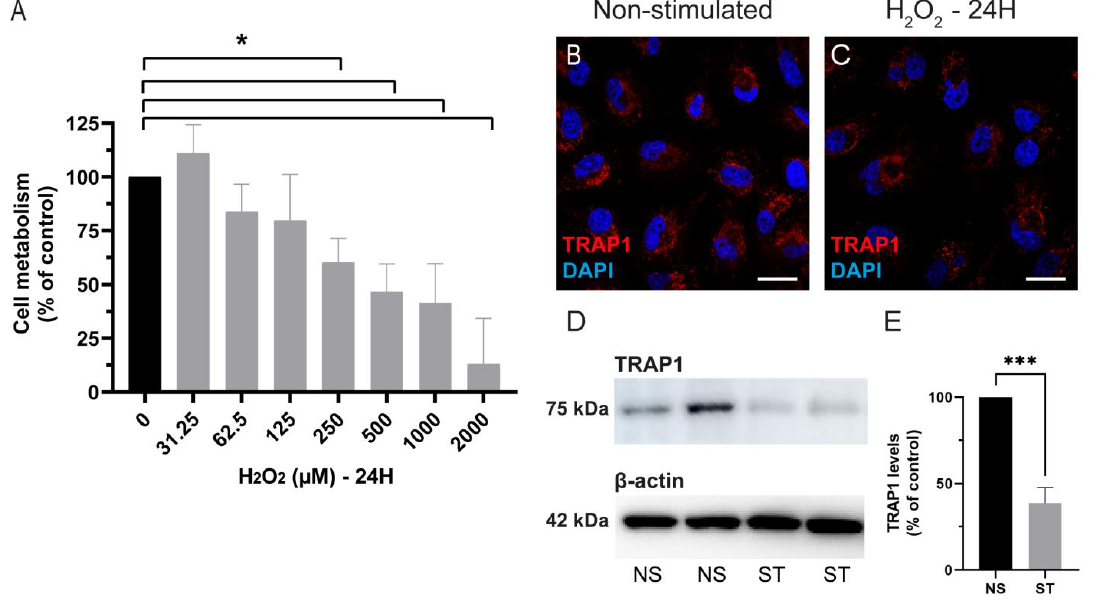
Figure 2. TRAP1 levels decrease upon challenge with hydrogen peroxide. ARPE-19 cells were treated with different doses of H 2 O 2 (0; 31.25; 62.5; 125; 125; 250; 500; 1000 and 2000 μM ) for 24 h ( A ). The dose of 500 μM was selected for the following experiments. ARPE-19 cells were treated, or not, with 500 μM H 2 O 2 for 24 h ( B – E ). Scale bars in ( B , C ) : 20 μm. Exposure to 500 μM H 2 O 2 for 24 h resulted in lower levels of TRAP1. NS: Non-stimulated (black bars); ST: stimulated with H 2 O 2 (grey bars). The values are presented as a percentage of the control (non-treated cells). Cell metabolism was assessed using the resazurin assay. Four independent experiments were performed ( n = 4). For the graph ( A ), statistical significance was calculated by using the Mann – Whitney U test. For the graph ( E ), statistical significance was calculated by using an unpaired t-test. Statistically significant values: * p < 0.05, ** p < 0.01, *** p < 0.001. In the graphs, all values are expressed as mean ± standard error of the mean (SEM).